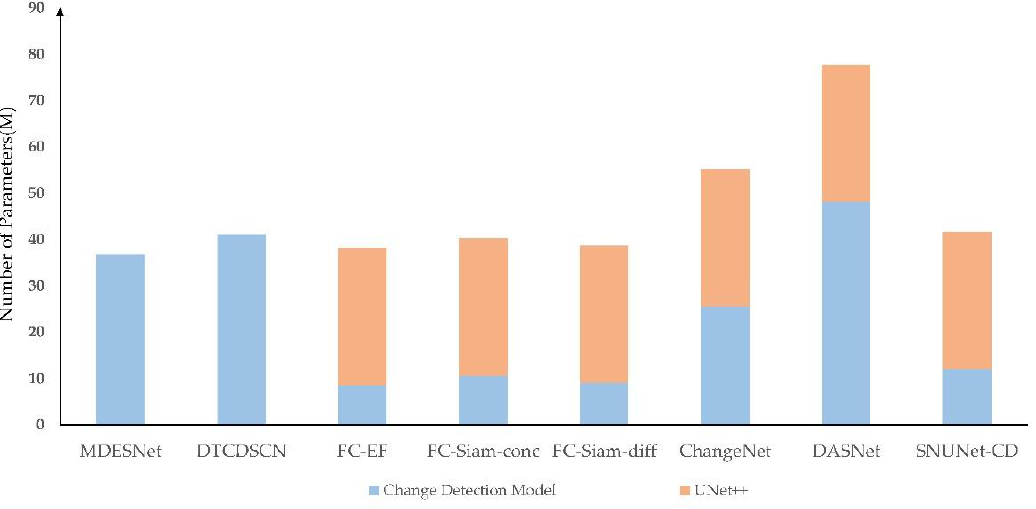
Figure 10. Comparison of the number of parameters between MDESNet, multitask model DTCDSCN, and 2 single-task models (change detection models and UNet++).